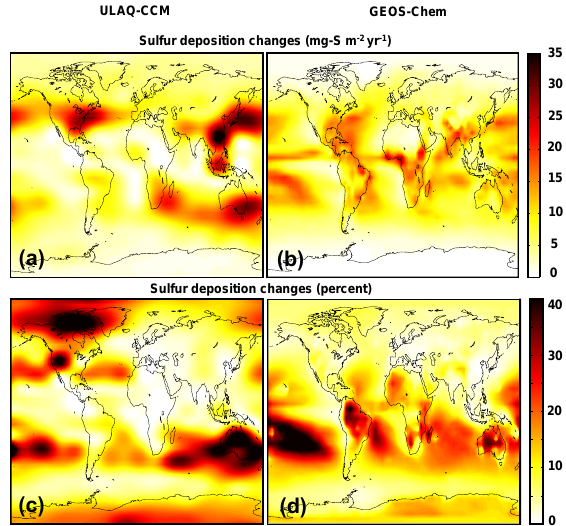
Figure 10. Annually averaged sulfur deposition flux changes (G4- Base) as a function of latitude and longitude for ULAQ-CCM in (a) and (c) (years 2030–2039) and GEOS-Chem in (b) and (d) (years 2000–2005). Panels (a) and (b) show absolute changes (mgSm − 2 yr − 1 ); (c) and (d) show percent changes with respect to the Base